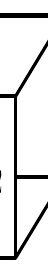
Figure 4. Two thermal zones.